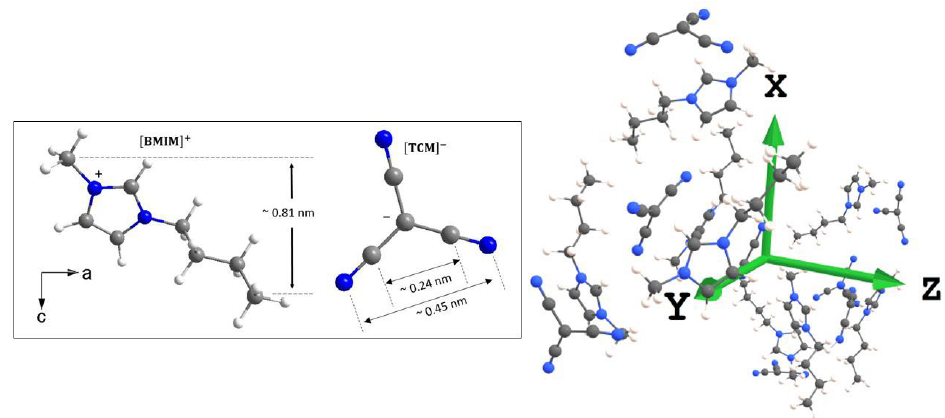
Figure 1. Left : A single molecule of the ionic liquid [BMIM] + [TCM] − used in this study. The [BMIM] + cation is the 1-butyl-3-methylimidazolium (C 8 H 15 N 2 ) molecule, and the [TCM] − is the tricyanomethanide (C 4 N 3 ) molecule. Right: The molecular arrangement of a cluster of IL molecules optimized using the ORCA software package [44,45]. Blue, grey, and white circles are nitrogen, carbon, and hydrogen atoms, respectively.